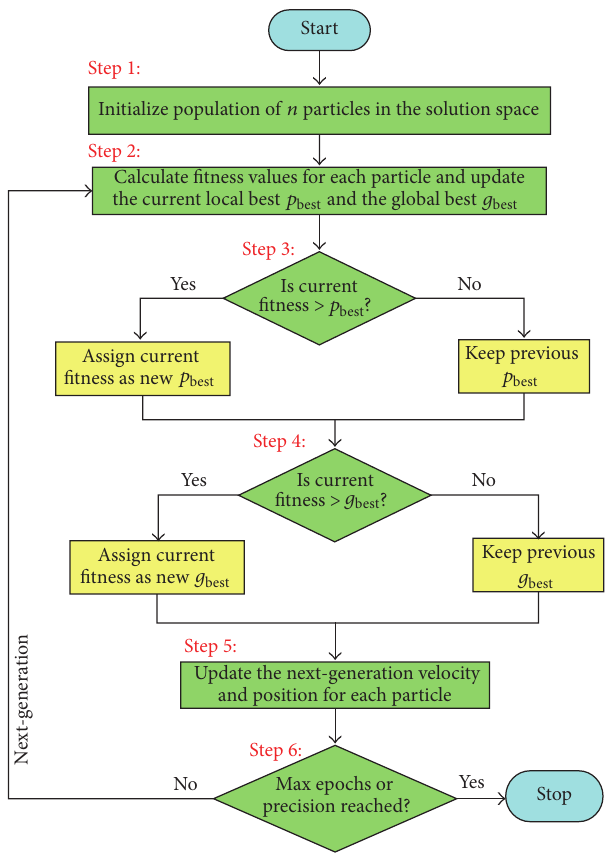
Figure 4: Process of proposed PSO